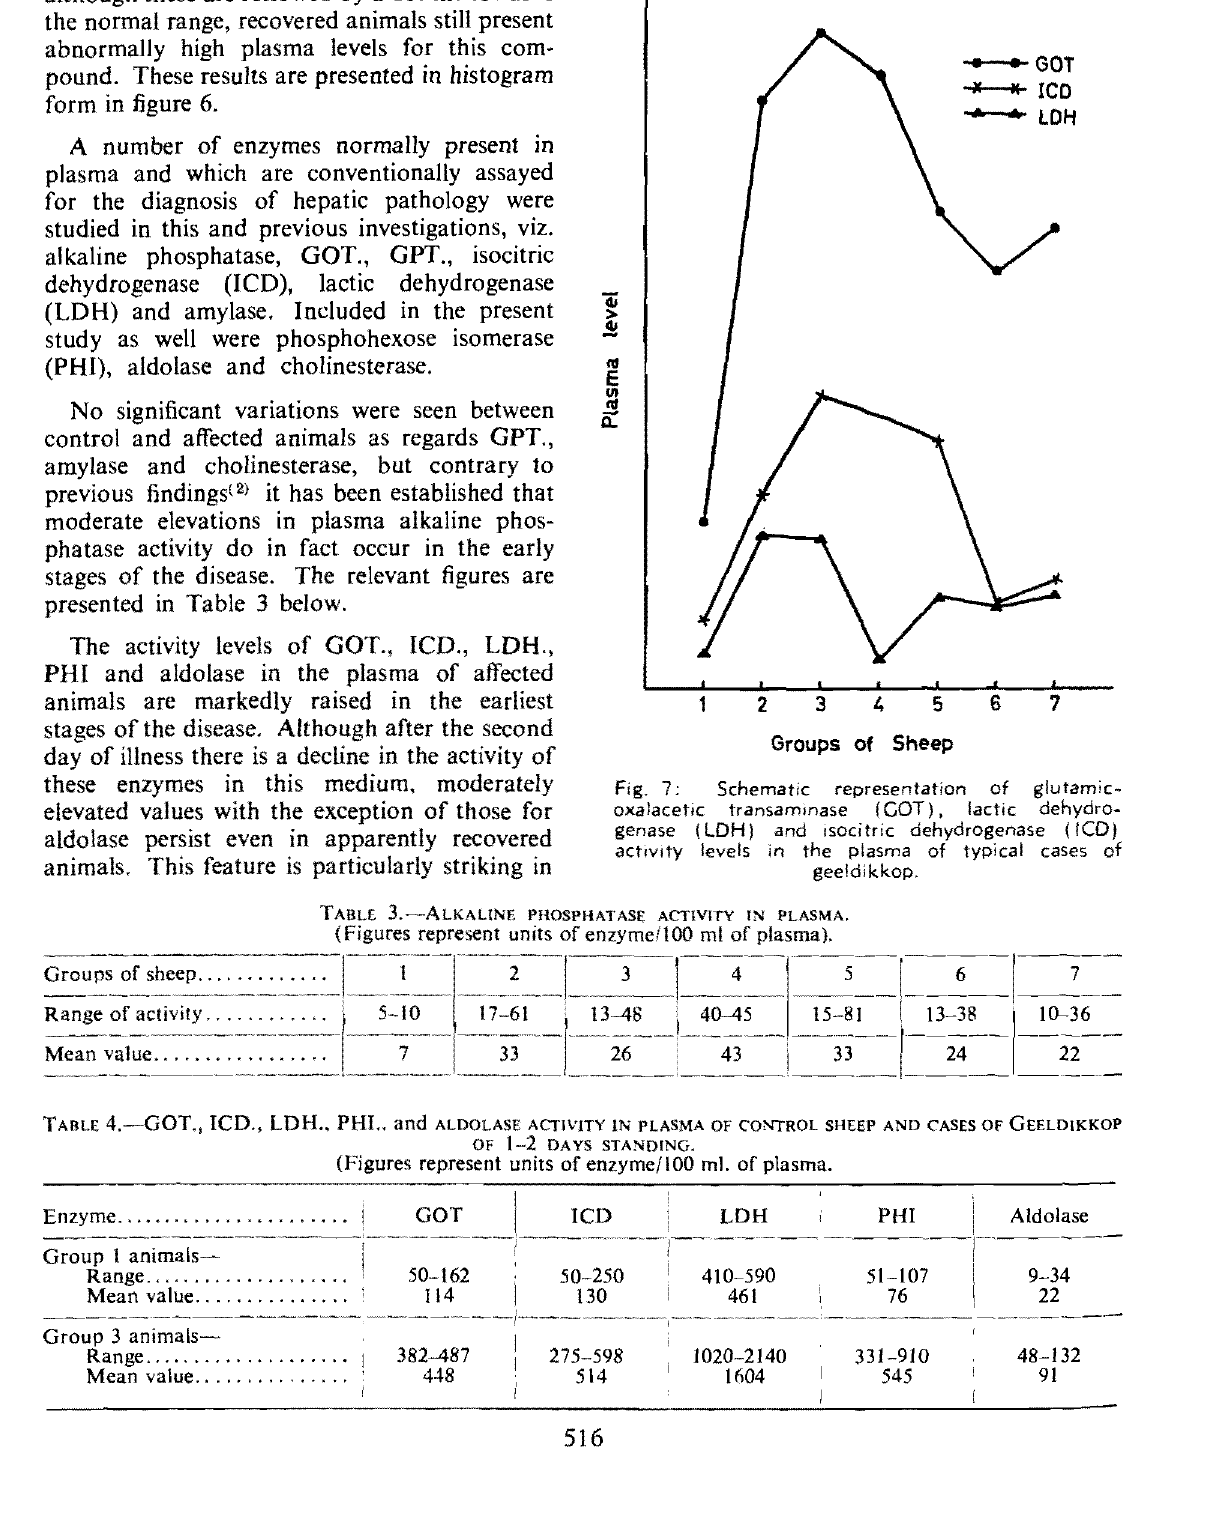
Fig. 7: Schematic representation of glutamic oxalacetic transammase (GOT) • lactic dehydro genase (LDH) and Isocitric dehydrogenase (ICD) act,v,ty levels in the plasma of typical cases of geeldikkop. TABLE 3.-ALKALINE PHOSPHATASE ACTIVITY IN PLASMA. (Figures represent units of enzymeilOO ml of plasma).